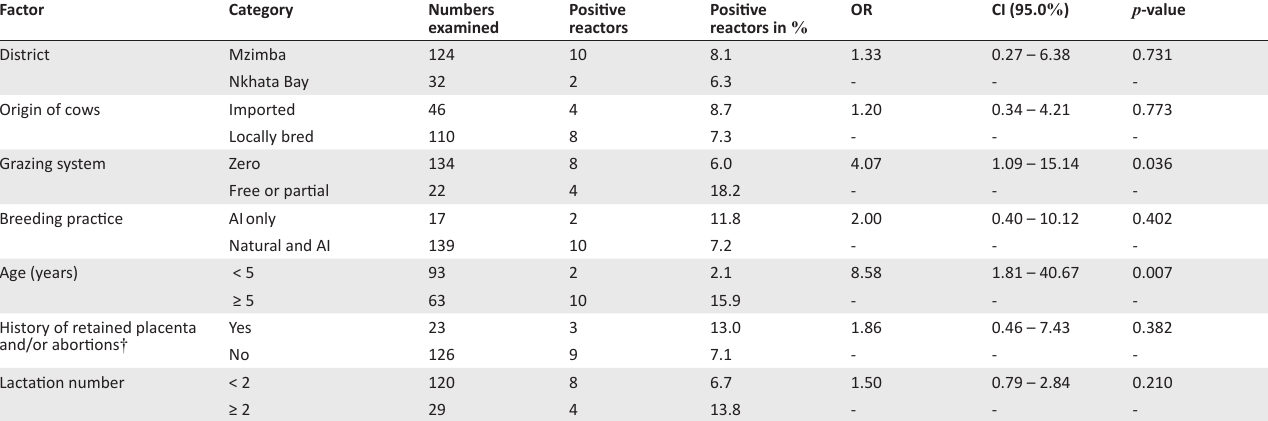
TABLE 3: Animal-level univariate logistic analysis of risk factors associated with brucellosis seroprevalence. Factor Category Numbers